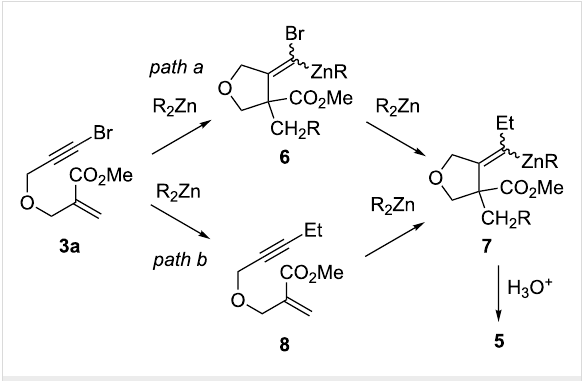
Scheme 3: Possible reaction pathways to account for the formation of product 5